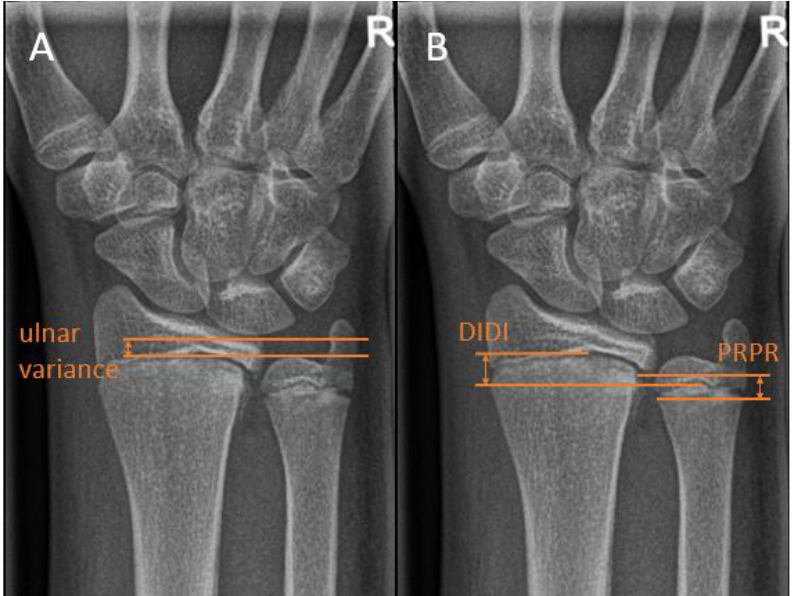
Figure 4. Distal ulna radiographic reference lines. ( A ) The Hafner method for measuring ulnar variance. ( B ) The method of perpendiculars for measuring ulnar variance, with ‘PRPR termed as the two most proximal points of the physis and ‘DIDI’ termed as the two most distal points of the physis.